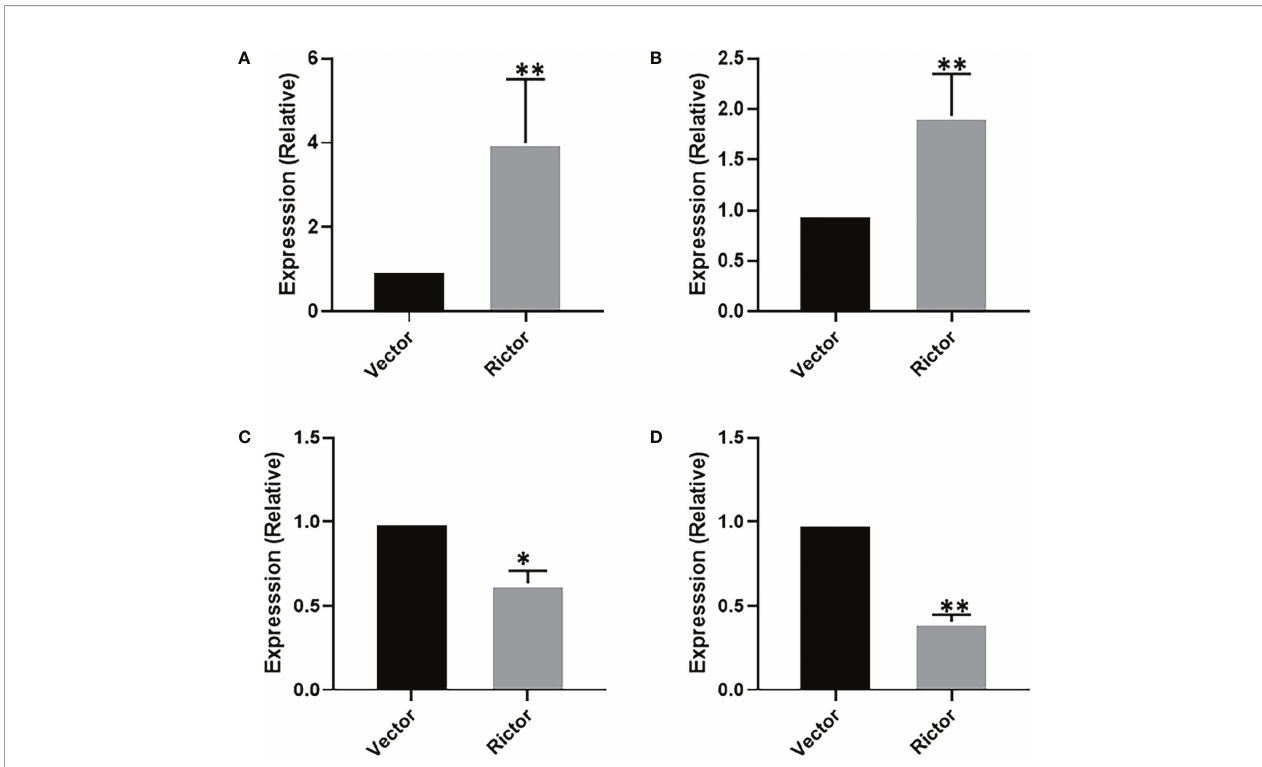
FIGURE 3 | Long-non coding RNAs modulating effect of Rictor in gastric cancer cell line SGC-7901. Transfection of Rictor plasmid increased the expression of lncRNAs (A) MALAT-1 and (B) GMAN and decreased the expression of lncRNAs (C) MEG3 and (D) GAS5. Values in control (vector-transfected cells were assigned a value of ‘ 1 ’ and those in Rictor-transfected cells are presented as comparative fold-change. *P < 0.05 and **P < 0.01, as calculated using the Student ’ s